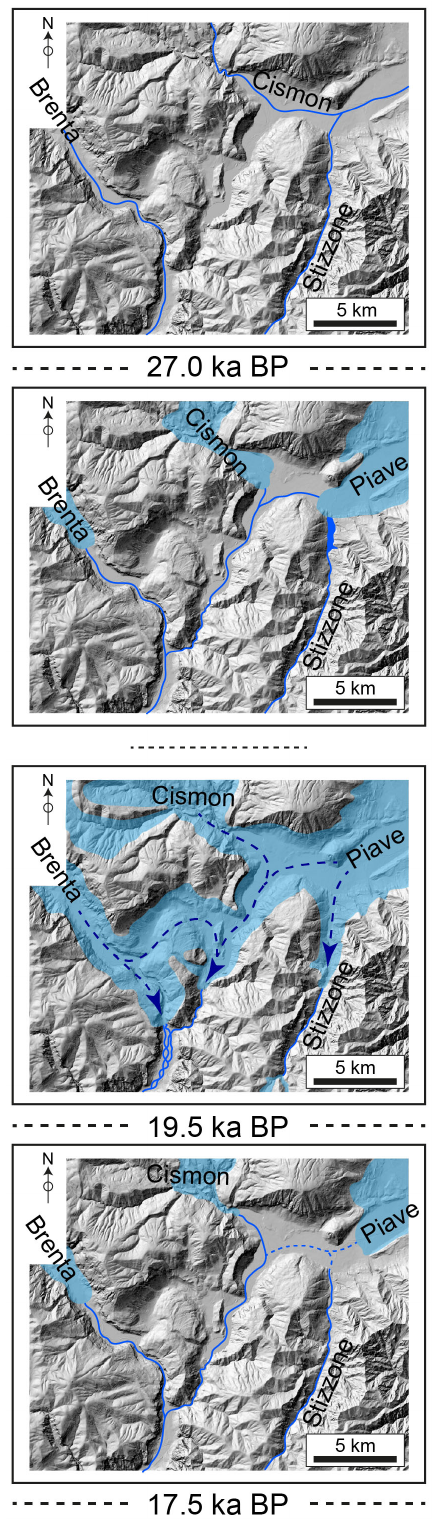
Figure 10. Evolution of the middle sector of the Valsugana Valley since the onset of the LGM; see text for